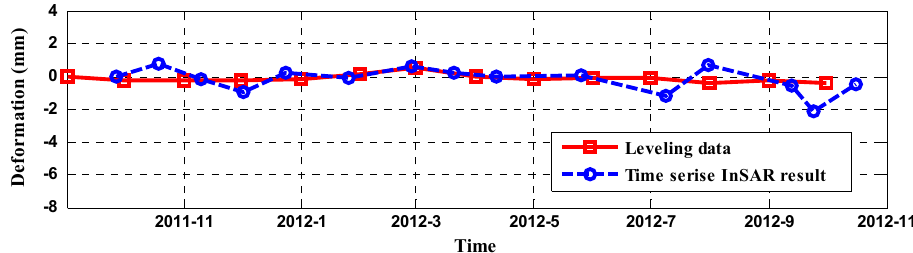
Figure 5. Time series analysis of F25 by layerwise mark leveling and PSI technique.